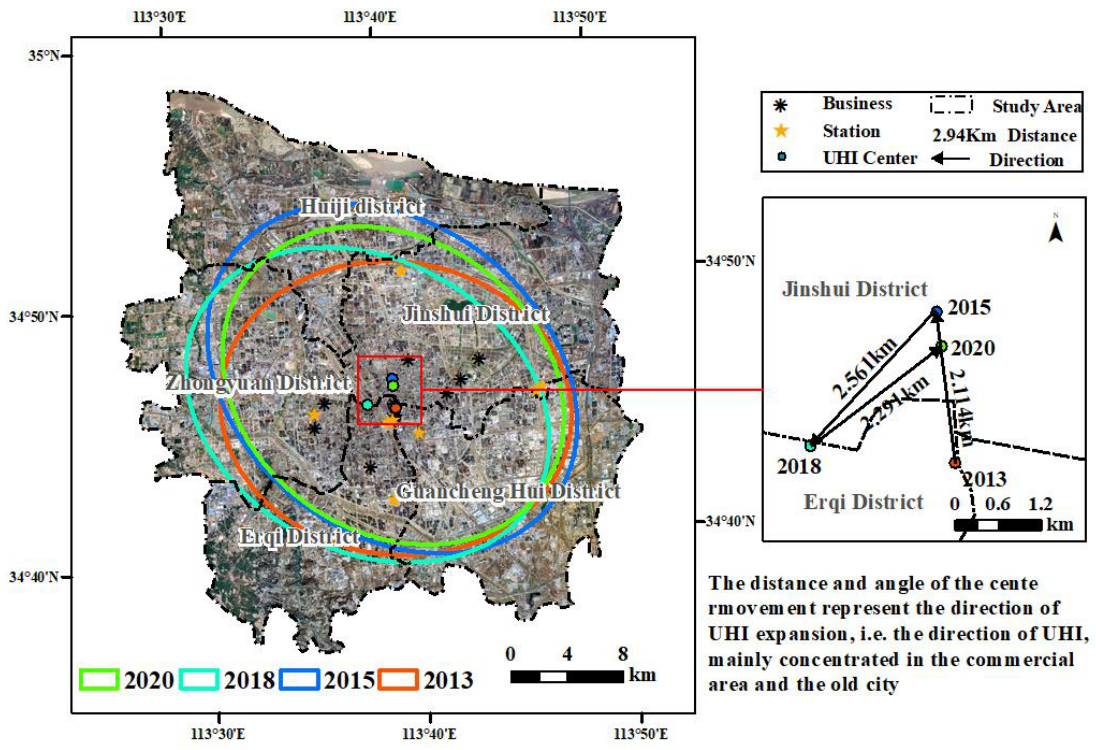
Figure 8. Directional distribution of UHI (the ellipse represents the gathering direction and posture of the heat island, and the point represents the spatial geometry center of the heat island).